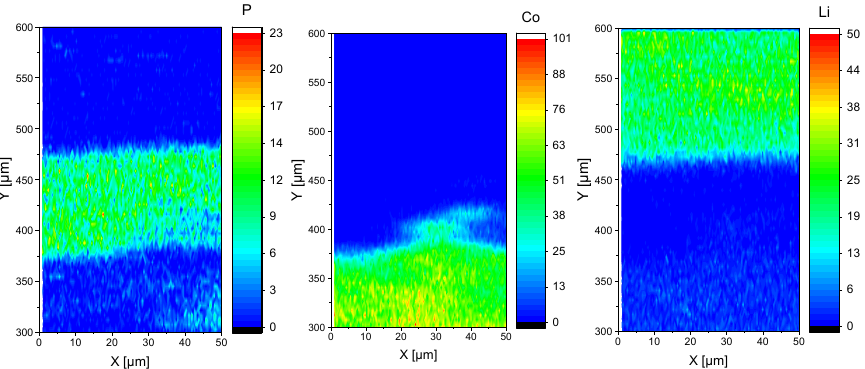
Figure 4. Exemplary elemental maps of the four major elements of the LCO + MEEP-based cell charged to 4.0 V. The map clearly shows the Li metal from Y = 470–600 µ m, the MEEP separator from Y = 370–470 µ m, and the LCO + MEEP from Y = 300–370 µ m. The layer structure of the MEEP-based cells is less clear and homogeneous compared to the LLZO-based cells.